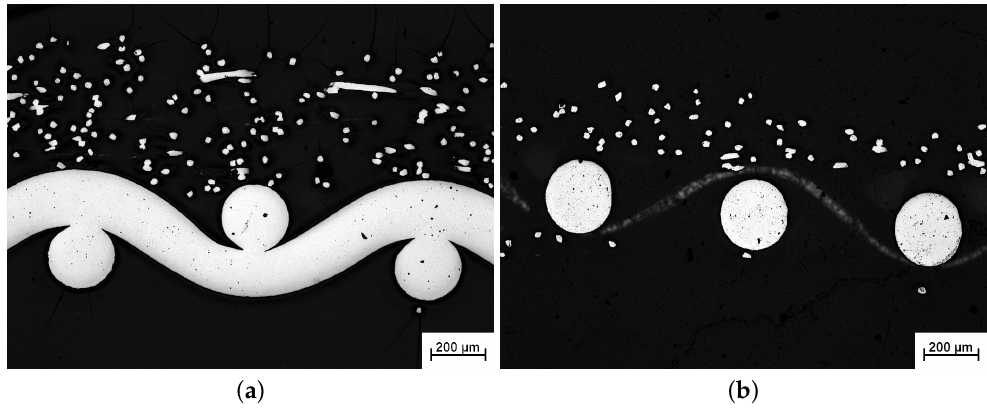
Figure 1. Light microscope images of Sintered Fiber Felts (SFF) before fouling. ( a ) SFF 100; ( b ) SFF 150.